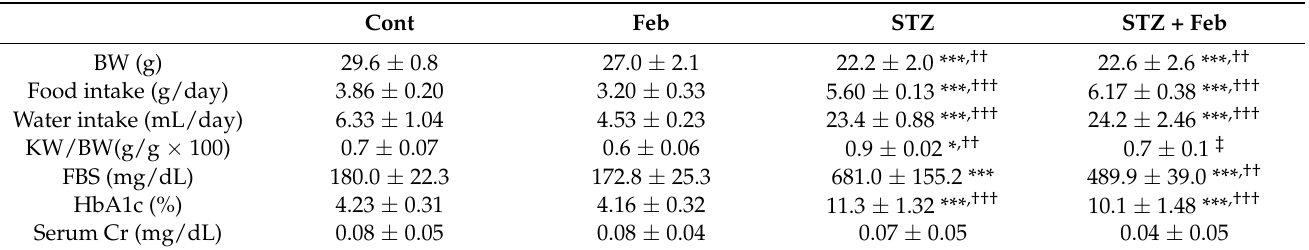
Table 1. Physical and biochemical parameters of the four groups at the end of the 8-week experi- mental period.